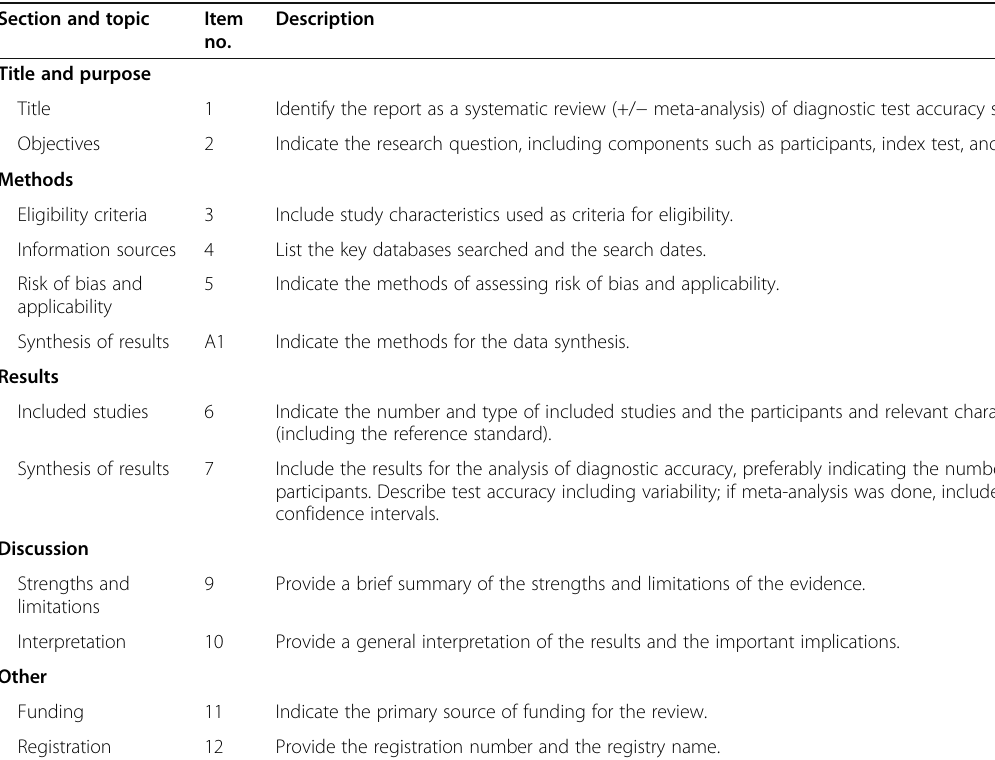
Table 1 PRISMA-DTA for Abstracts checklist Section and topic